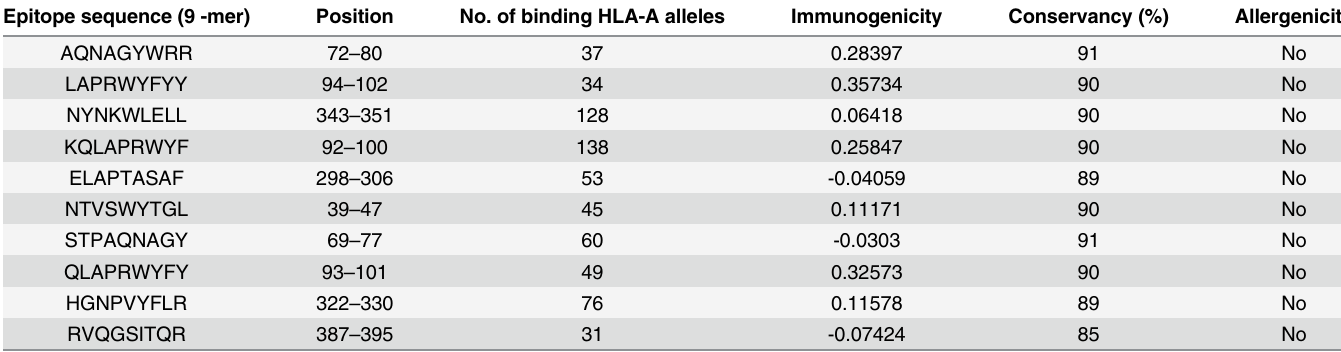
Table 5. CTL epitopes of the N protein of MERS-CoV selected on the basis of maximum HLA binding alleles. Epitope sequence (9 -mer) Position No. of binding HLA-A alleles Immunogenicity Conservancy (%) Allergenicity AQNAGYWRR